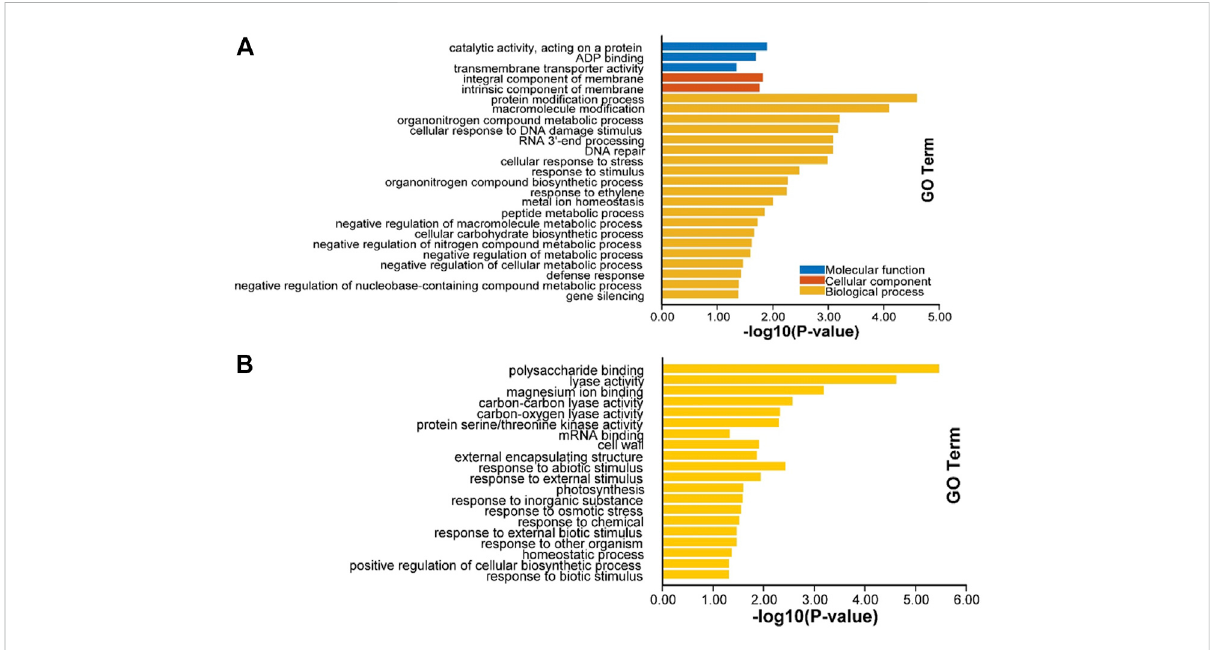
FIGURE 6 GO enrichment of differentially expressed genes between NIL176 and Guichao 2. (A) : GO enrichment of up-regulated genes in NIL176 compared with Guichao 2. (B) : GO enrichment of down-regulated genes in NIL176 compared with Guichao